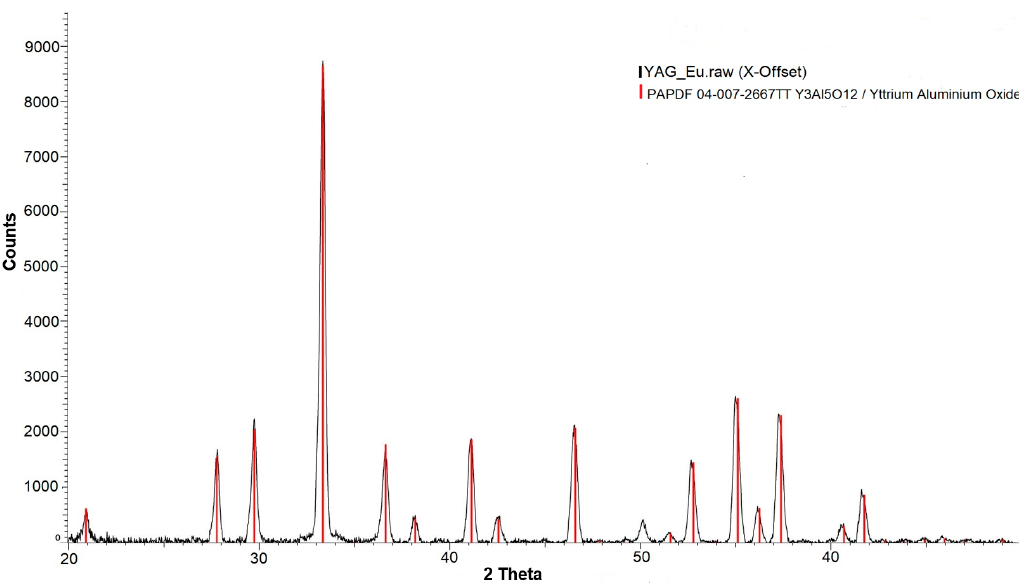
Figure 1. X-ray di ff raction spectra of YAG:Eu (2%). Figure 1. X-ray diffraction spectra of YAG:Eu (2%). The X axis of the XRD spectra is the 2 Theta (2Q), when Q is the angle of reflection of the X-rays. The Y axis of an XRD pattern corresponds to the intensity of the